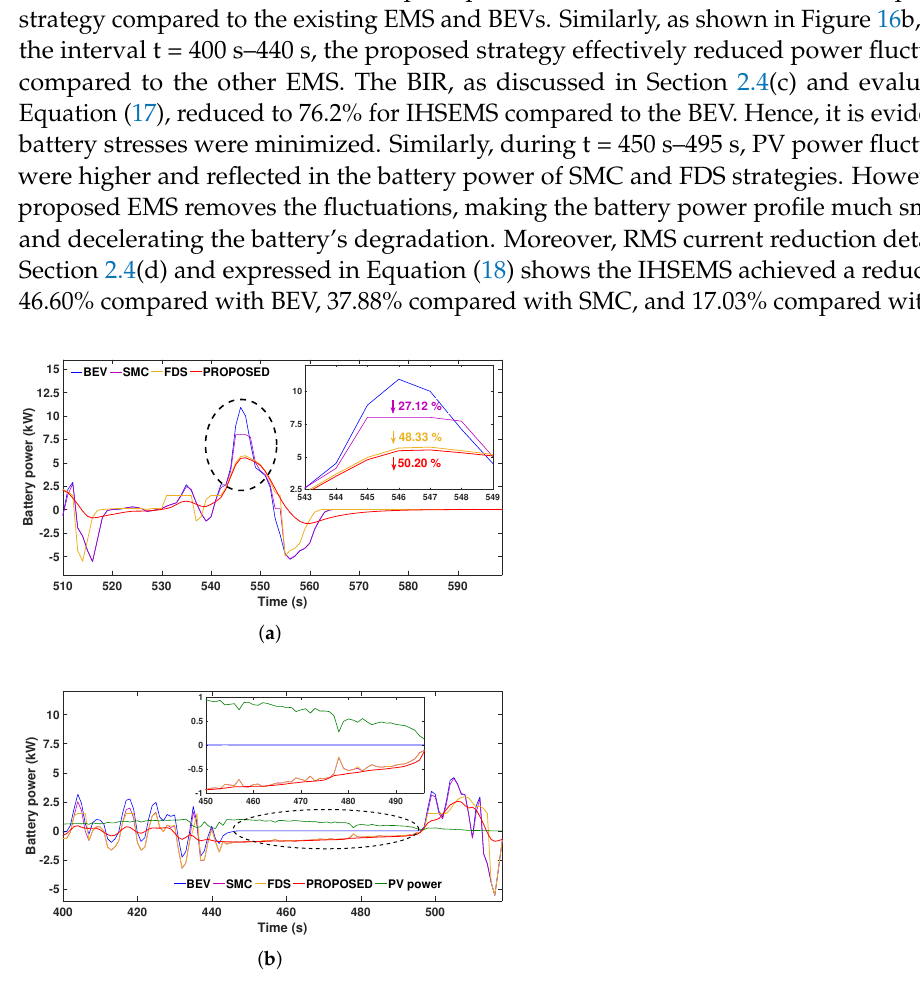
Figure 16. Comparison of BEV, SMC, FDS, and proposed IHSEMS under NYCC driving cycle. ( a ) Comparison of peak battery power for NYCC driving cycle (510 s–599 s). ( b ) Comparison of power fluctuations for NYCC driving cycle (400 s–520